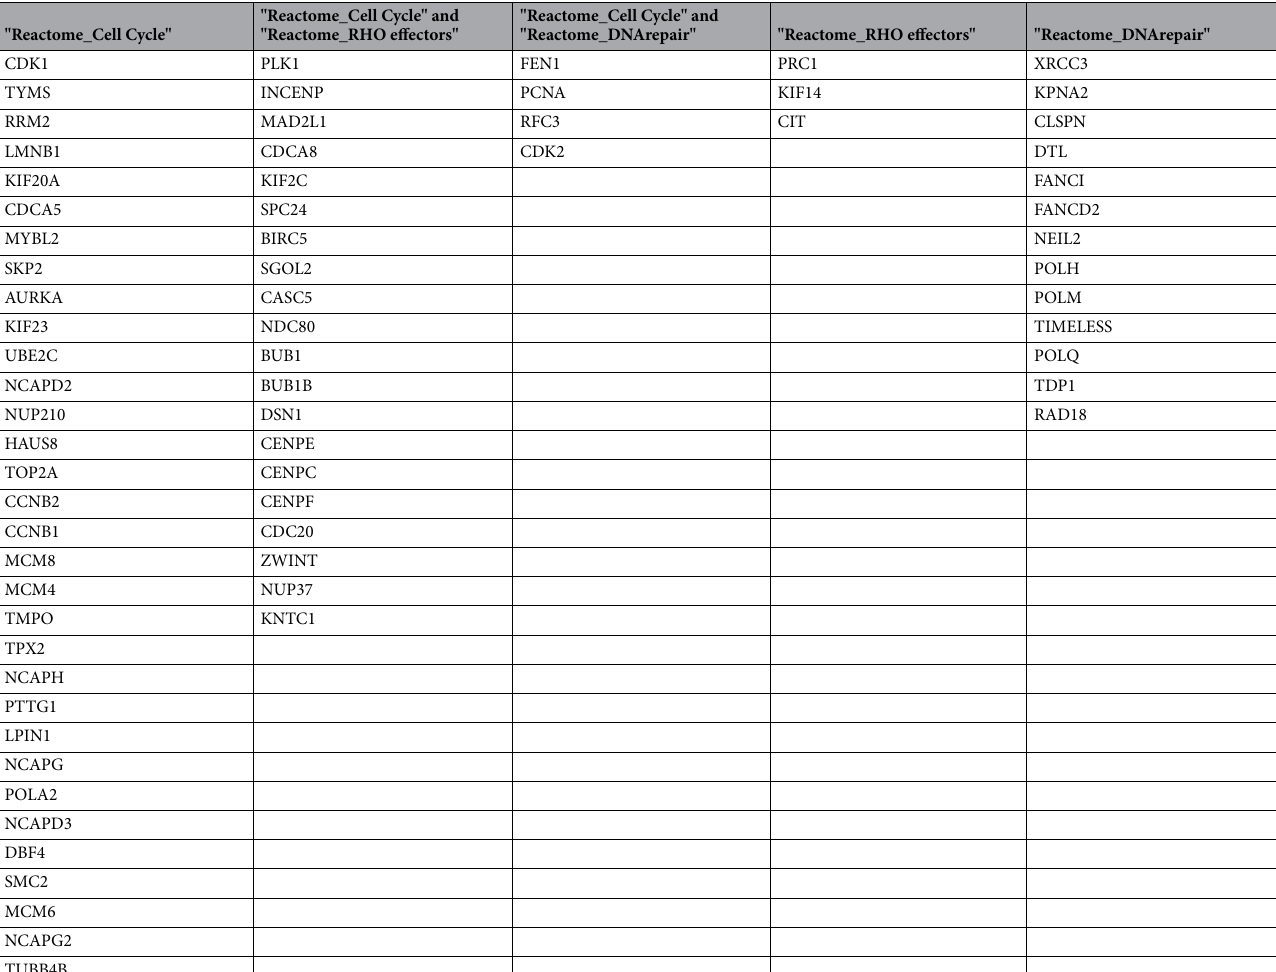
Table 1. Table with a list of the most differentially expressed genes shortlisted from the RNA-Seq analysis (Ratio > 1.5 on Vehicle-treated samples) in relation to their direct regulation of the most effected pathways (Enrichr).